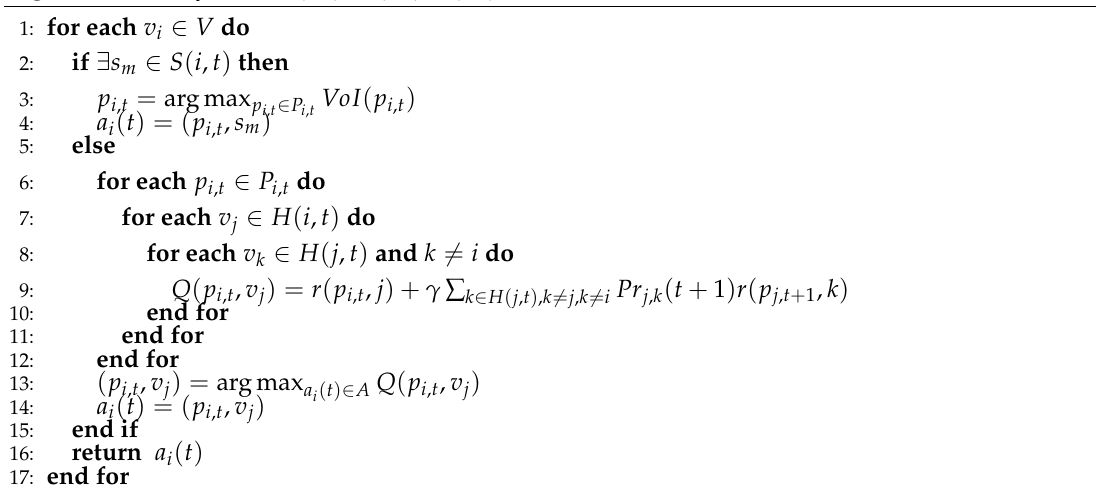
Algorithm 2 RelaySelect( S ( i , t ) , H ( i , t ) , P ( i , t )